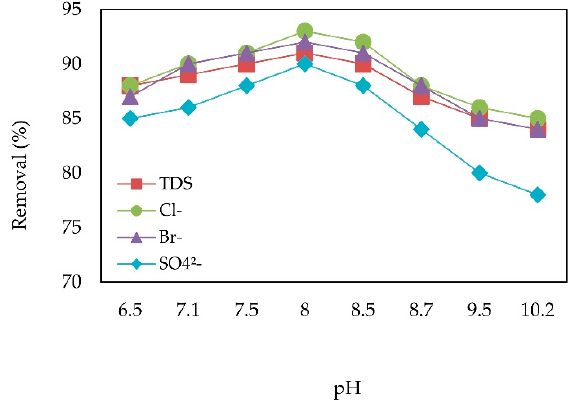
Figure 4. pH effect at optimal conditions (applied current density [I] = 2.0 mA/cm 2 , reaction time [RT] = 80 min).